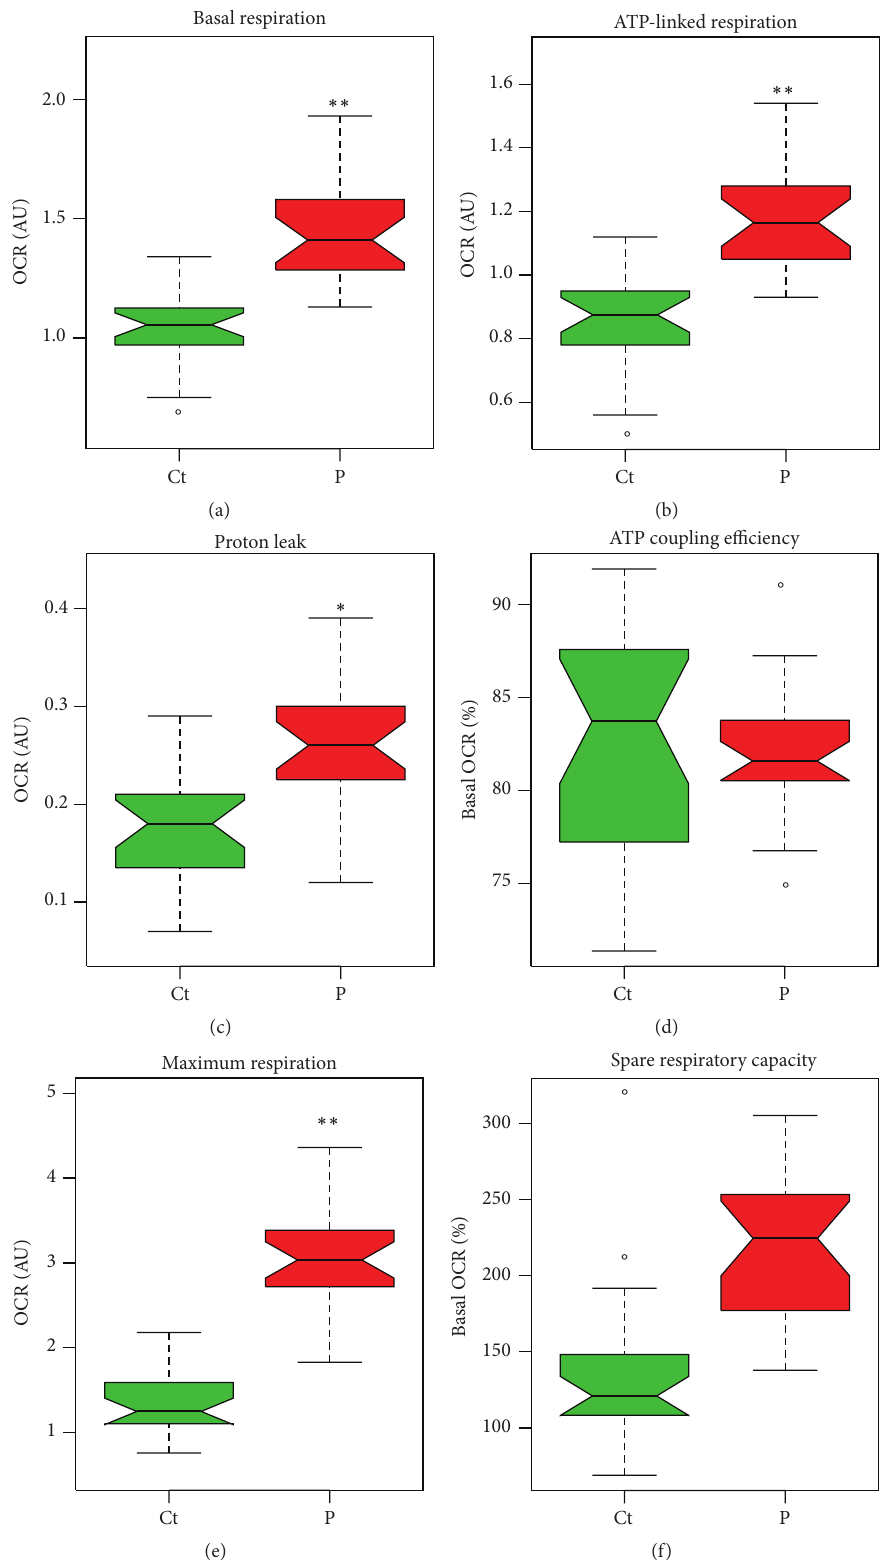
Figure 2: Parameters of respiratory control in patient-derived and control fibroblasts. Boxplots depict grouped patients (P) and control (Ct) values. (a) Basal mitochondrial OCR. (b) ATP-linked OCR. (c) OCR due to proton leak. (d) ATP coupling efficiency (percentage OCR due to ATP synthesis). (e) Maximum OCR. (f) Percentage spare respiratory capacity. ∗ 𝑝 < 0.05 ; ∗∗ 𝑝 < 0.01 ; ∘ , outlier; AU, arbitrary units; OCR, oxygen consumption